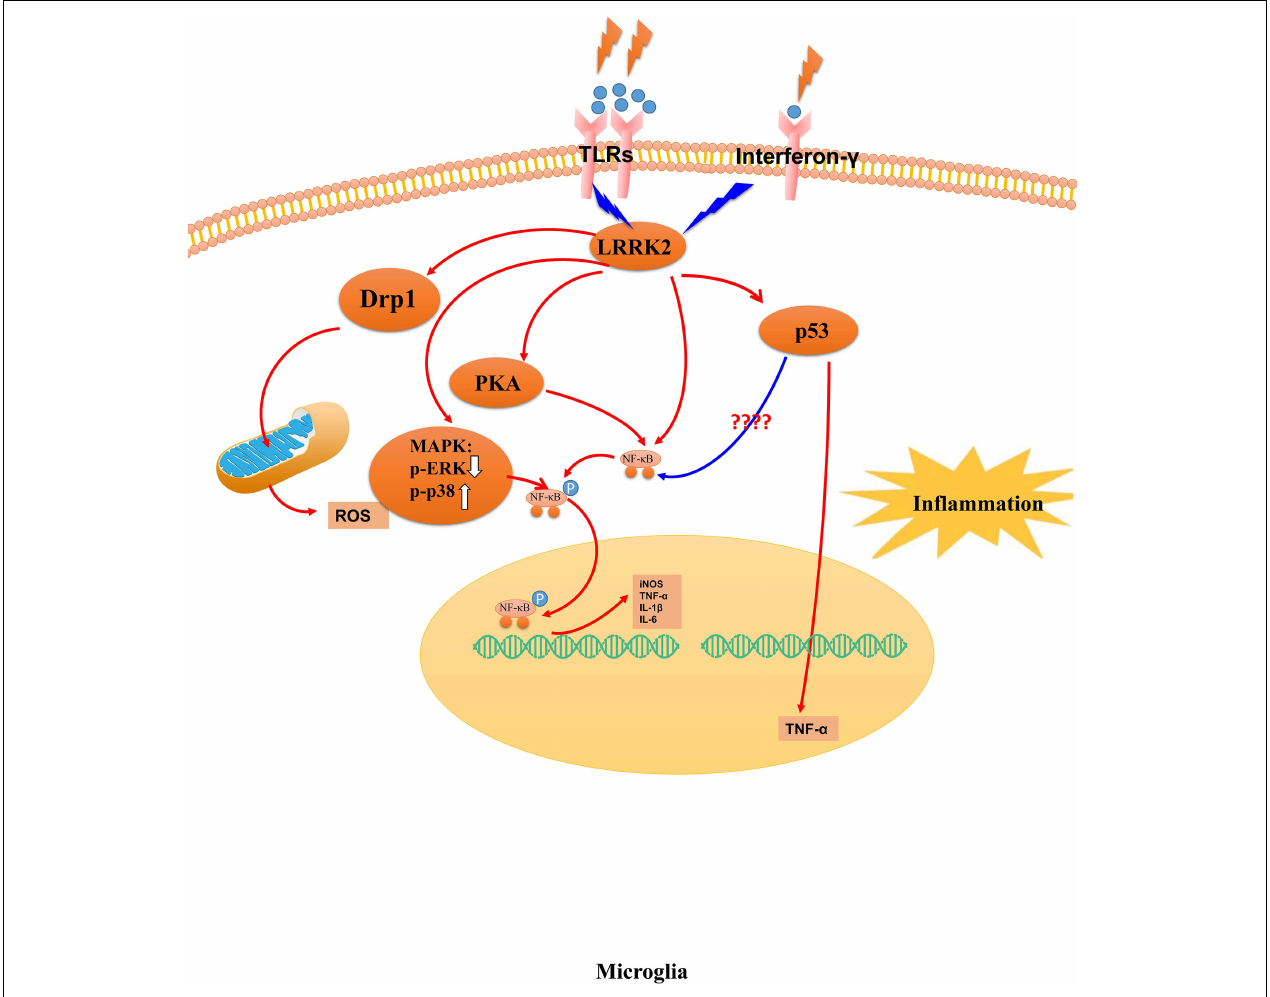
FIGURE 2 | The mechanism of LRRK2 leading to microglia activation. Abnormal LRRK2 activity could regulate microglia cells’ activation through hyperphosphorylation of PKA, p53, MAPK family proteins, and Drp1. Thus, LRRK2 drives microglia toward a reactive phenotype with enhanced cell activity and inflammation in response to inflammatory stimuli, including LPS, environmental insults, and neuronal